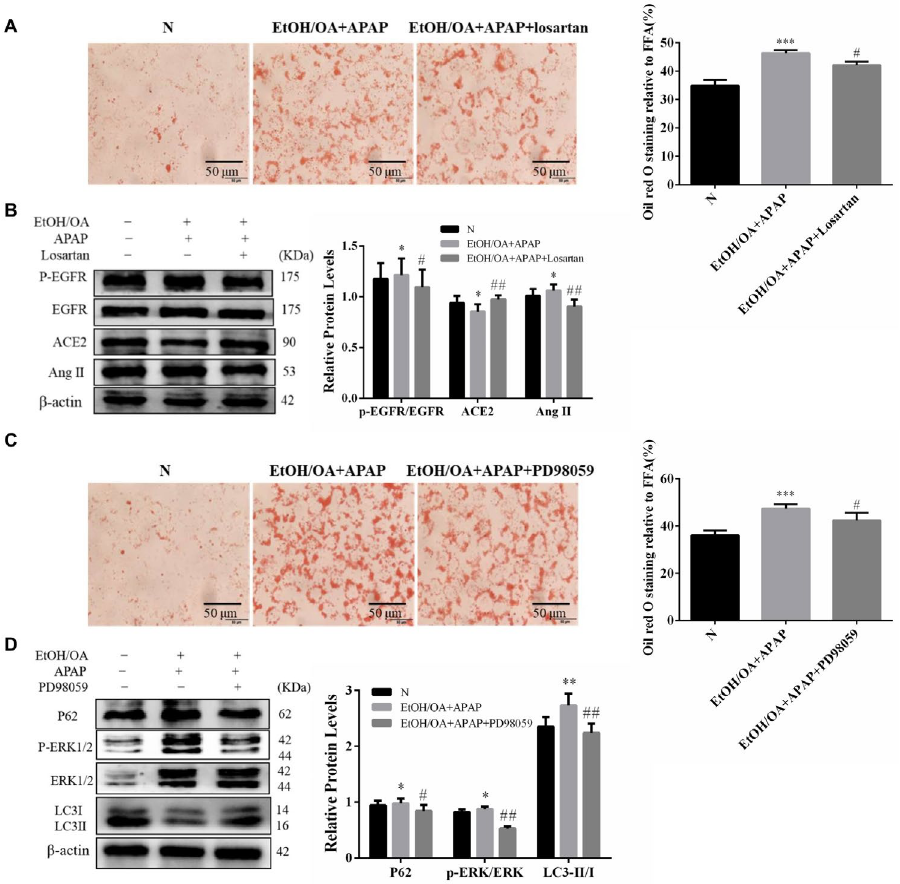
Figure 8. Inhibition of Ang II and ERK1/2 alleviated lipid accumulation and restored autophagic flux in L02 cells. Pretreatment with losartan or PD98059 one hour before cell modeling. ( A ) Representative images of ORO staining with losartan (2 µ M) in L02 cells (Scale bar = 50 µ m). ( B ) Western blot analysis of ACE2, Ang II and p-EGFR/EGFR protein levels. ( C ) Representative images of ORO staining with PD98059 (40 µ M) in L02 cells (Scale bar = 50 µ m). ( D ) Western blot analysis of p-ERK/ERK, P62 and LC3 II/I protein levels. Data represent the mean ± SEM ( n = 3 independent experiments). * p < 0.05 vs. N group; ** p < 0.01 vs. N group; *** p < 0.001 vs. N group; # p < 0.05 and ## p < 0.01 vs. EtOH/OA + APAP group.